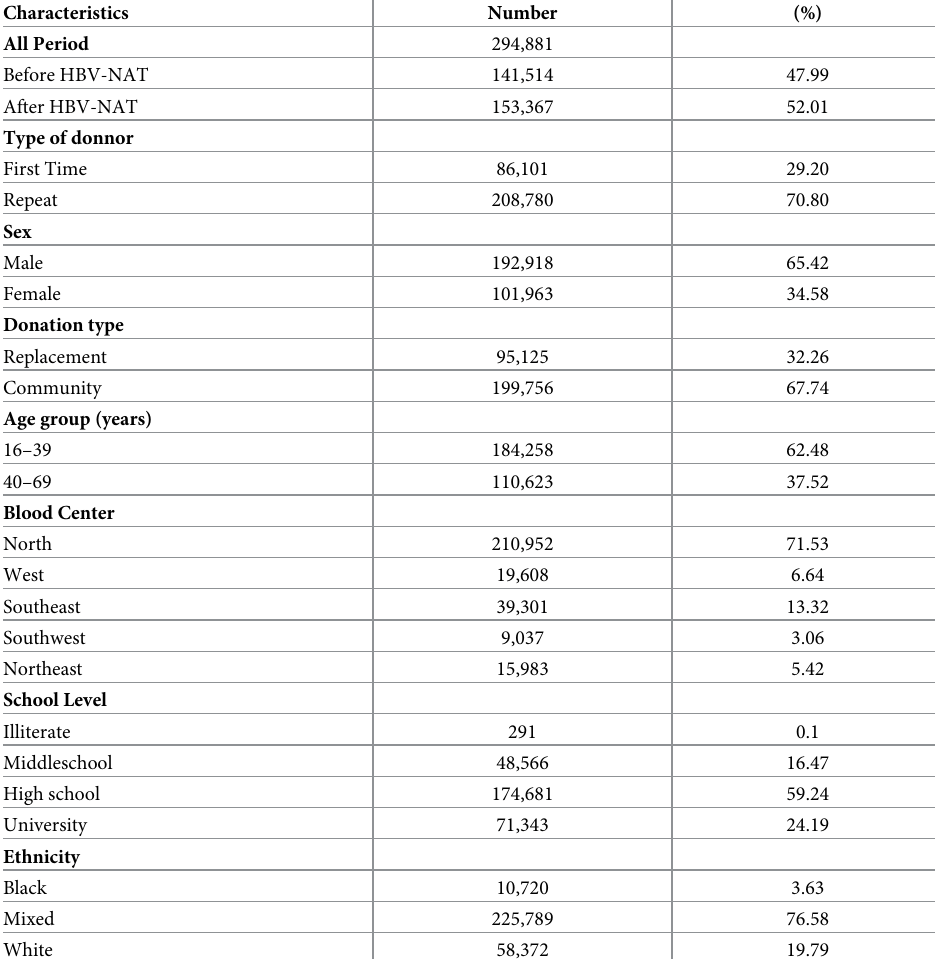
Table 1. Donation characteristics.